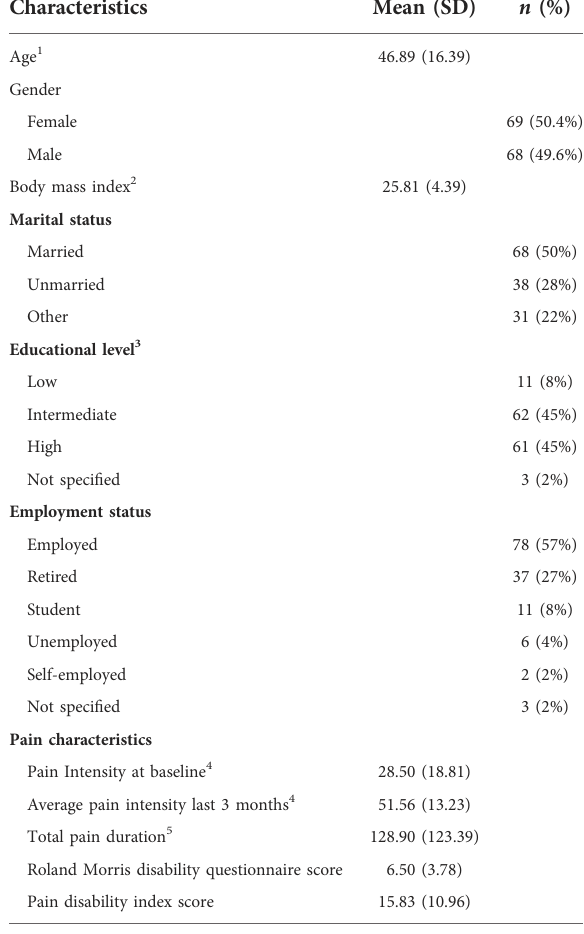
TABLE 2 Demographics, pain, and disability of 137 chronic low back pain patients.